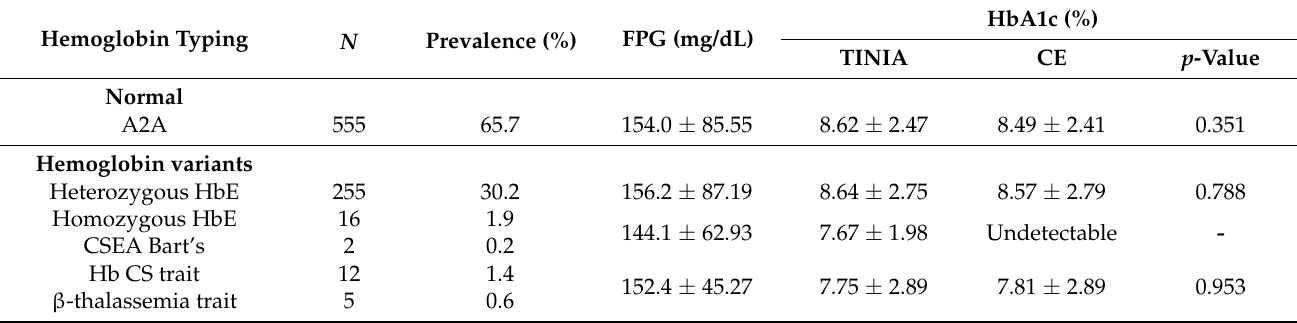
Table 1. Hb typing and HbA1c level in diabetes patients.